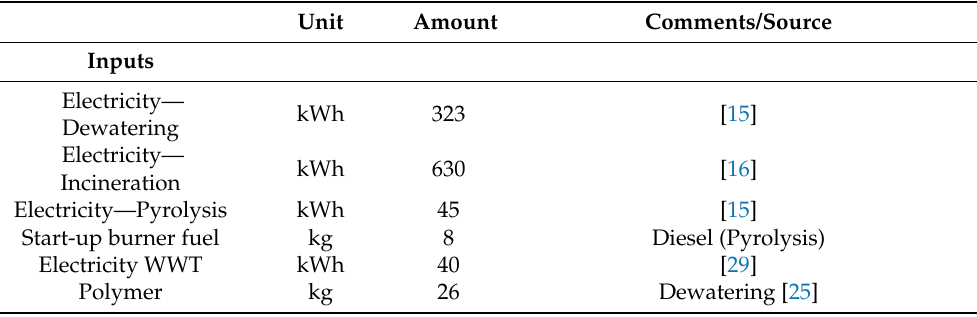
Table 1. Inventory data for pyrochar production and its application in CHP plants (expressed per 2.8 t dry sludge,